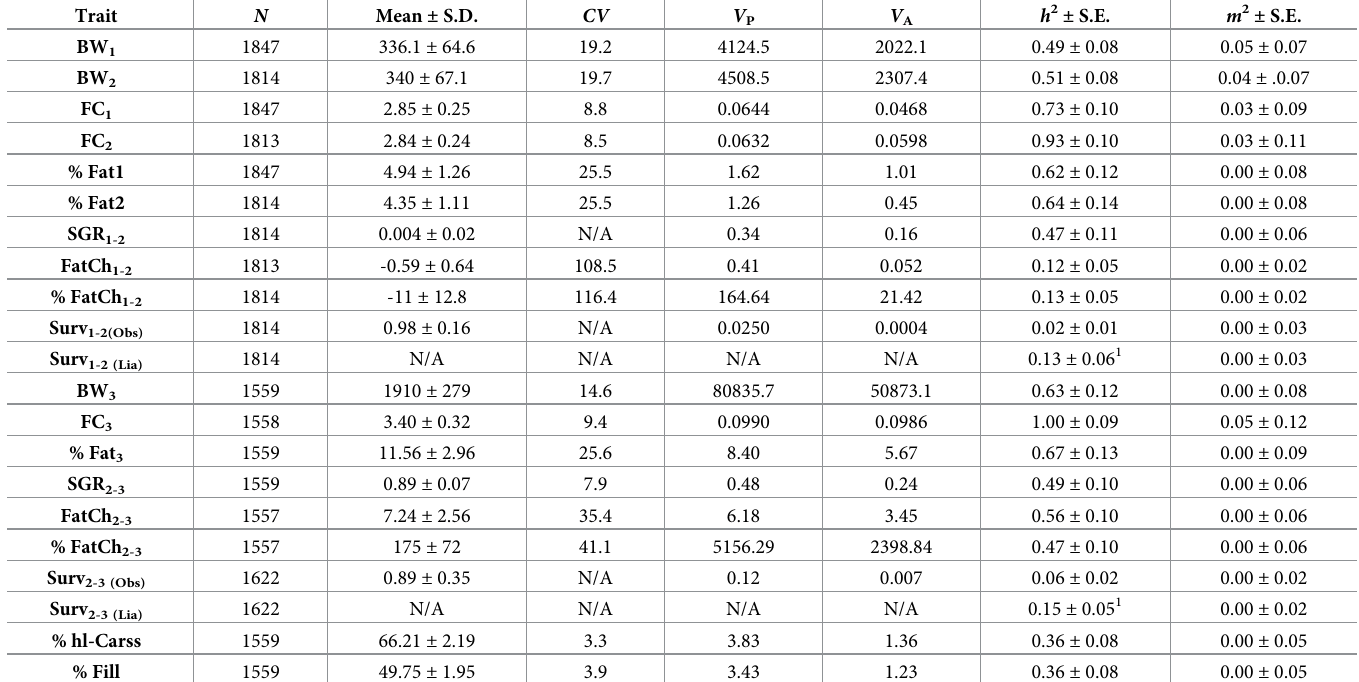
Table 1. Number of observations ( n ), traits means (mean ± S.D.), CV (coefficient of variation), V P (phenotypic variance), V A (genetic variance), h 2 (heritability estimates ± S.E.), m 2 (maternal effect ± S.E.) for traits within each studied period ( 1 before winter period , 2 after winter period , 3 at harvest) and for traits changes during 1–2 overwintering period and 2–3 growing